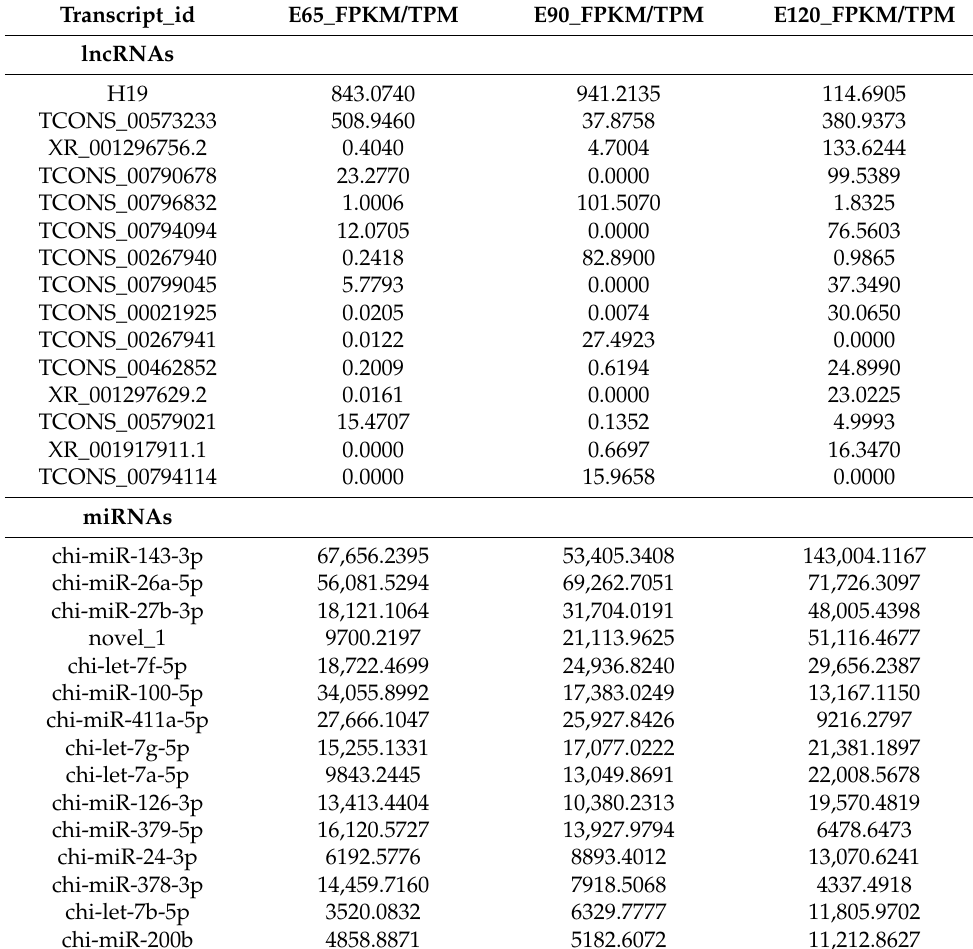
Table 2. The information of top 15 up-DE